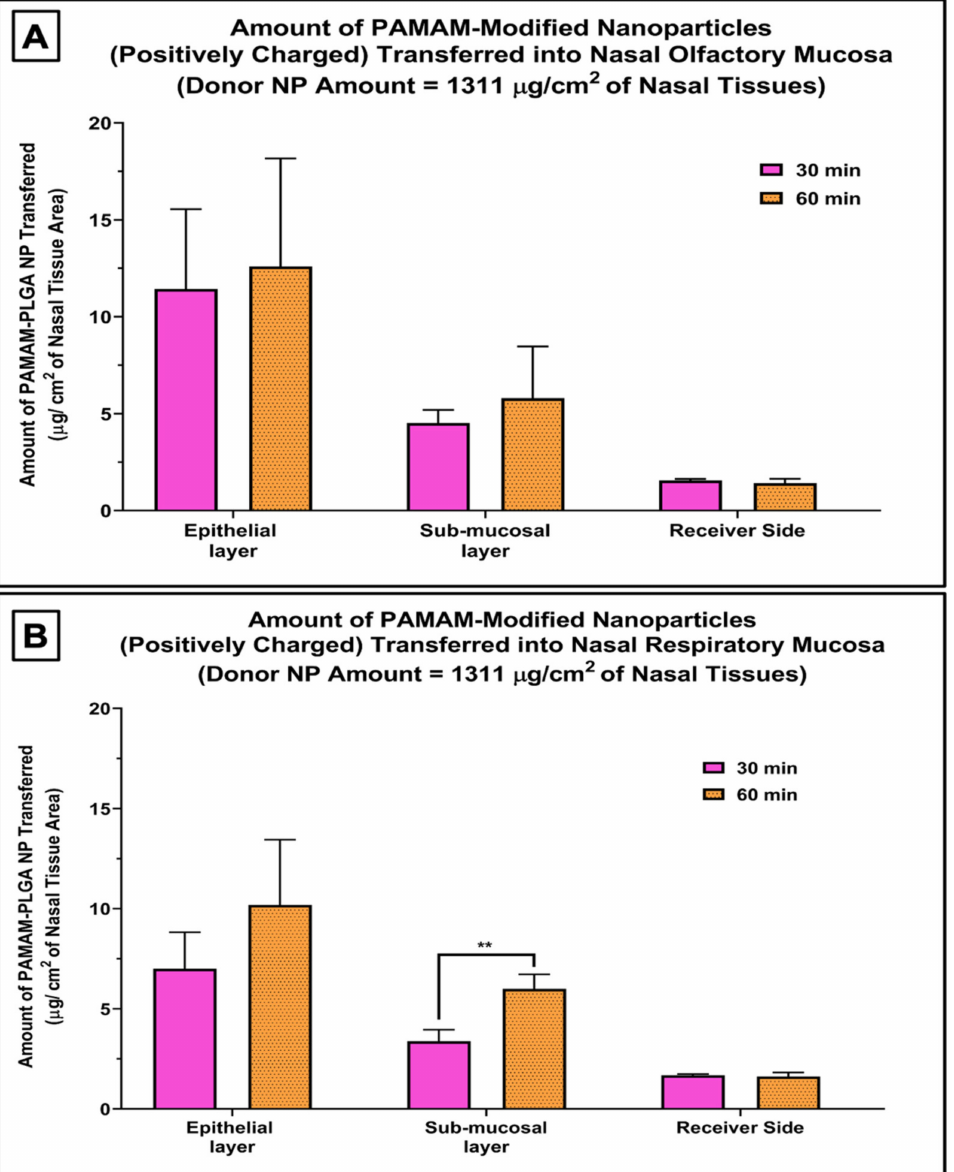
Figure 3. Amount of nanoparticles quantified in each mucosal compartment and the receiver media in nasal olfactory mucosa ( A ), and respiratory mucosa ( B ) following incubation with the PAMAM-modified nanoparticles (cationic PLGA NP) for 30 and 60 min normalized per tissue surface area. The two tailed t-test was applied to evaluate the statistical significance. Bars are mean ± SD. ** p -value = 0.007, n = 3